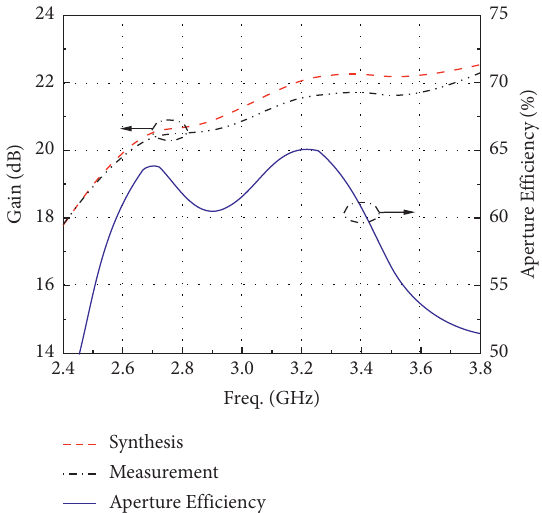
Figure 14: The synthesis aperture efficiency and the comparison of measured and synthesis gains.